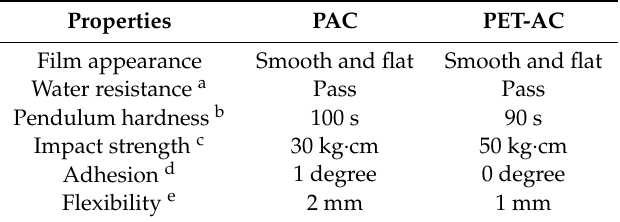
Table 4. The properties of aminoacrylic coating